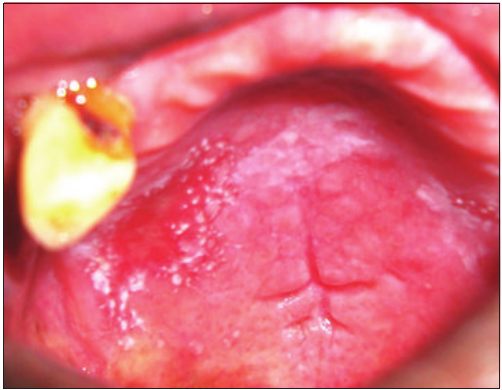
Figure 2: Intraoral picture showing the palate.